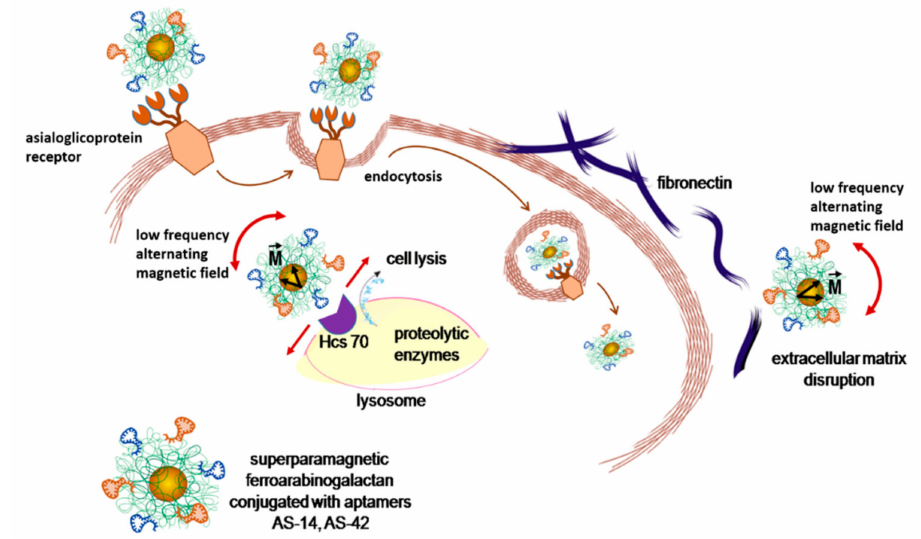
Figure 4. Schematic representation of asialoglycoprotein receptor-mediated delivery and cell damage by AS-FrFeAG nanoparticles at a low alternating magnetic field. Due to a magnetic moment (M) of nanoparticles, they oscillate in an alternating magnetic field. AS-FrFeAG binds to fibronectin via aptamer AS-14 and disrupts extracellular matrix; AS-FrFeAG is internalized via asialoglycoprotein receptors and binds to Hsc70 via aptamer AS-42 causing lysosome damage and leakage of proteolytic enzymes resulting in cell